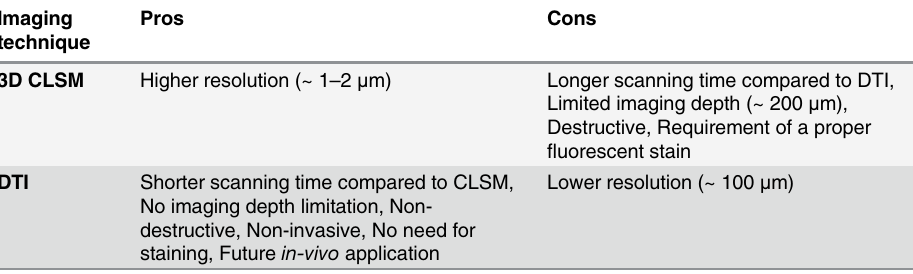
Table 1. Comparison of the pros and cons of CLSM and DTI modalities. Overall, DTI has more advan- tages to study TE cardiovascular